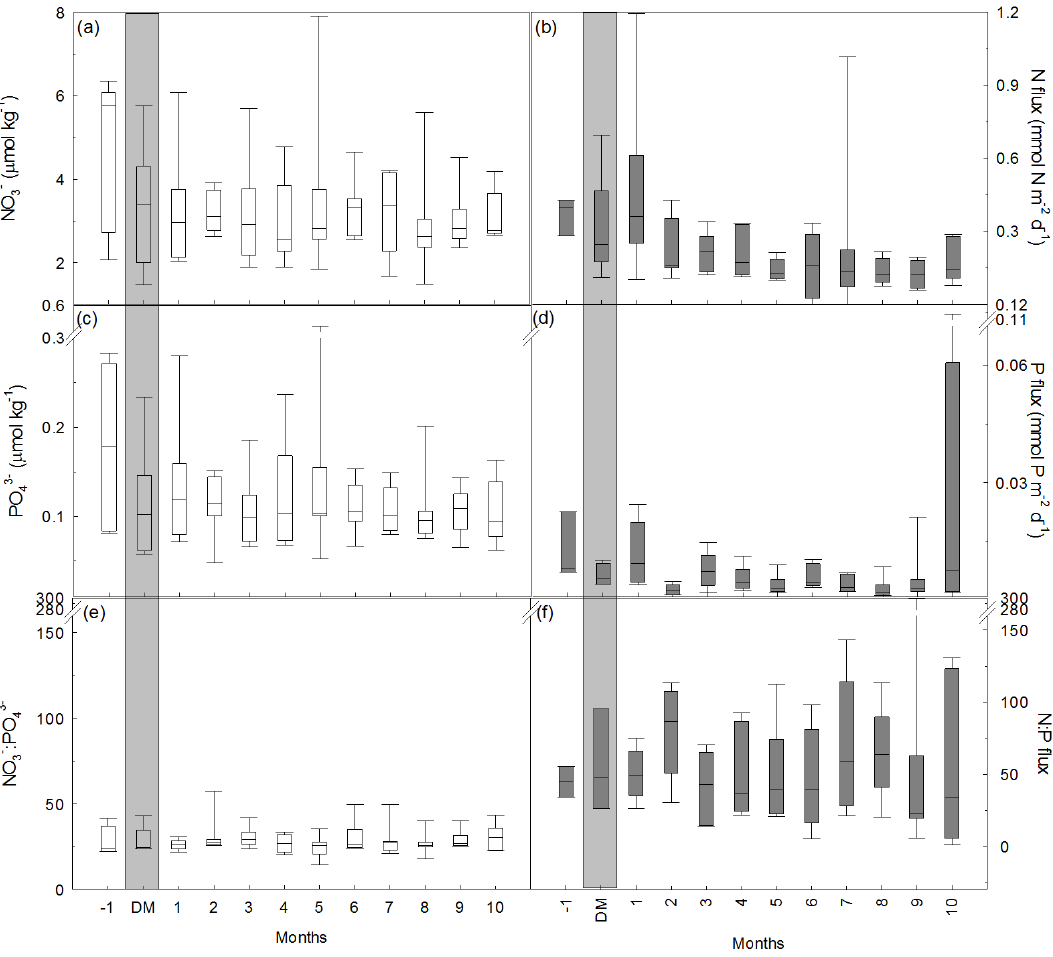
Figure 8. Box–whisker plot comparing the annual variation in NO − 100–500m (data used are from January 2005 to December 2011). The gray bar represents the period of deep mixing (DM) for each year. All else as in Fig.